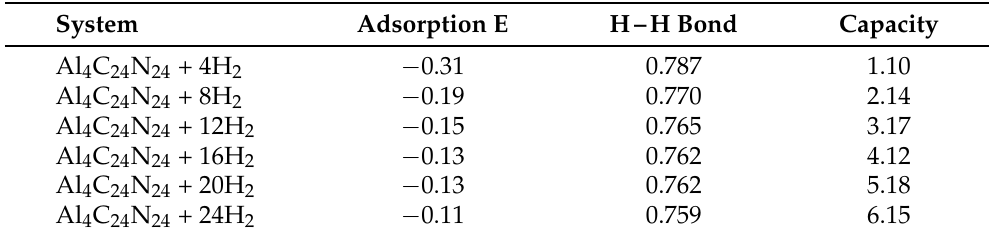
Figure 8. ( a , b ) Charge density difference for the Al-doped g-CN with multiple adsorbed H 2 molecules. Yellow regions indicate charge gain and blue regions indicate charge loss. The isosurface of charge density is set to 0.0016 e/Bohr 3 . Table 1. The adsorption energy (E Ad , in eV) per H 2 on Al-doped g-CN, the averaged H–H bonding length (in Å), and the hydrogen-storage capacity